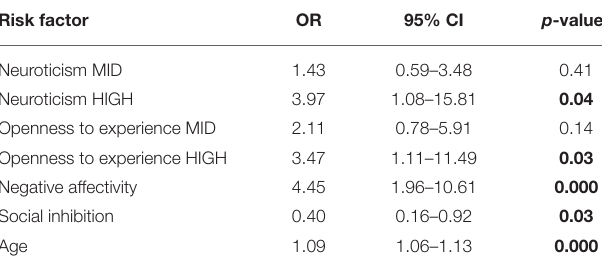
TABLE 3 | Multivariate logistic regression model predicting belonging to breast cancer group based on personality traits. Risk